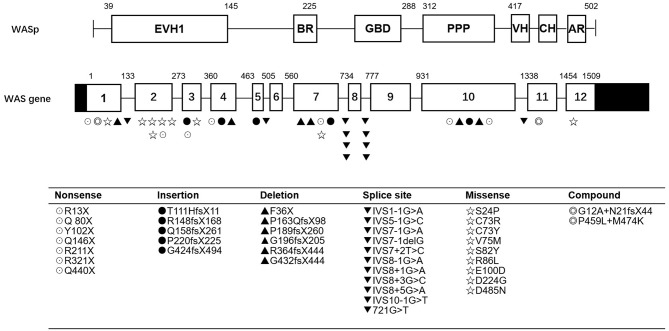
WASP mutations identified in 42 patients. EVH1, Ens/VASP homology 1 domain; BR, basic region; GBD, GTPase bending domain; PPPP, proline-rich region; VH, verprolin homology; CH, cofilin homology; AR, acidic region.